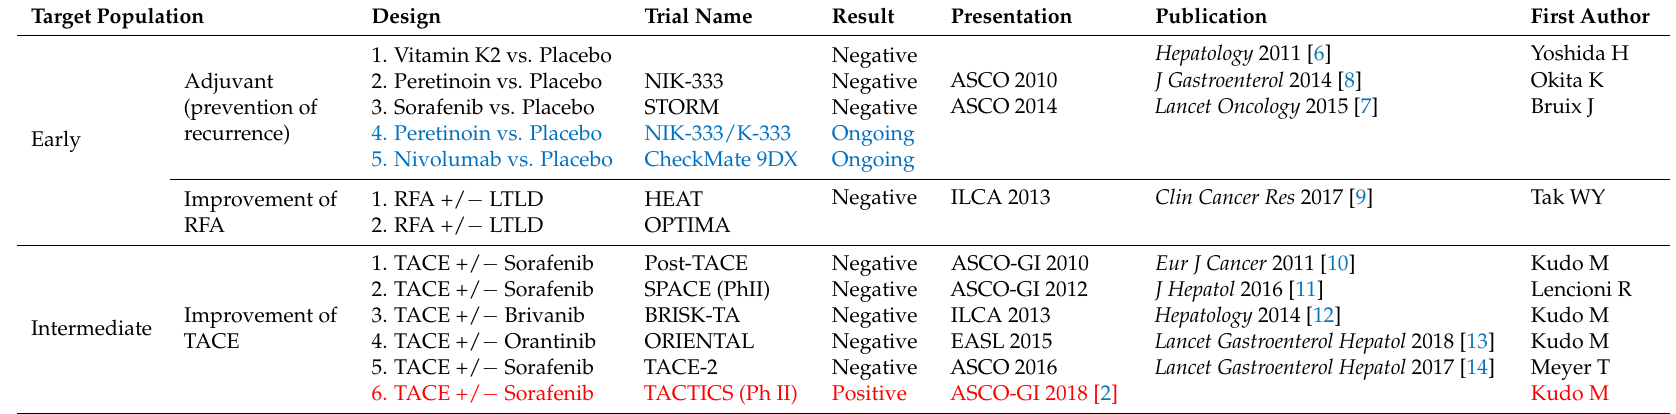
Table 1. Randomized phase II, phase III clinical trials of early/intermediate stage hepatocellular carcinoma